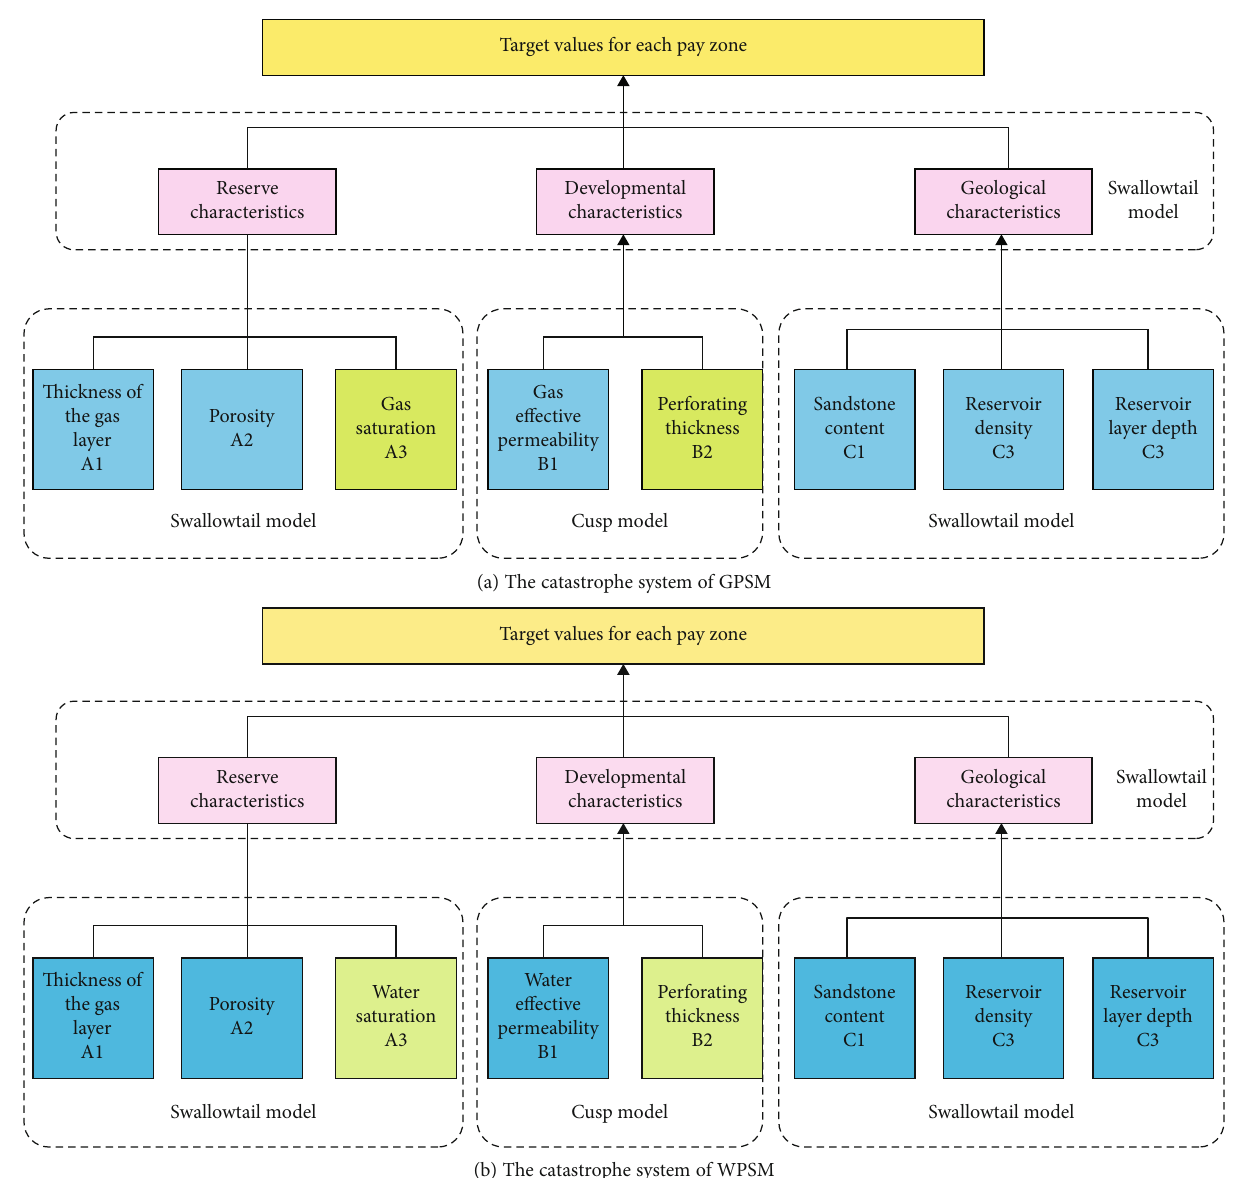
Figure 1: The schematic of the catastrophe system for gas and water. Final target values are yellow, development feature target values are pink, static variables are blue, and dynamic variables are